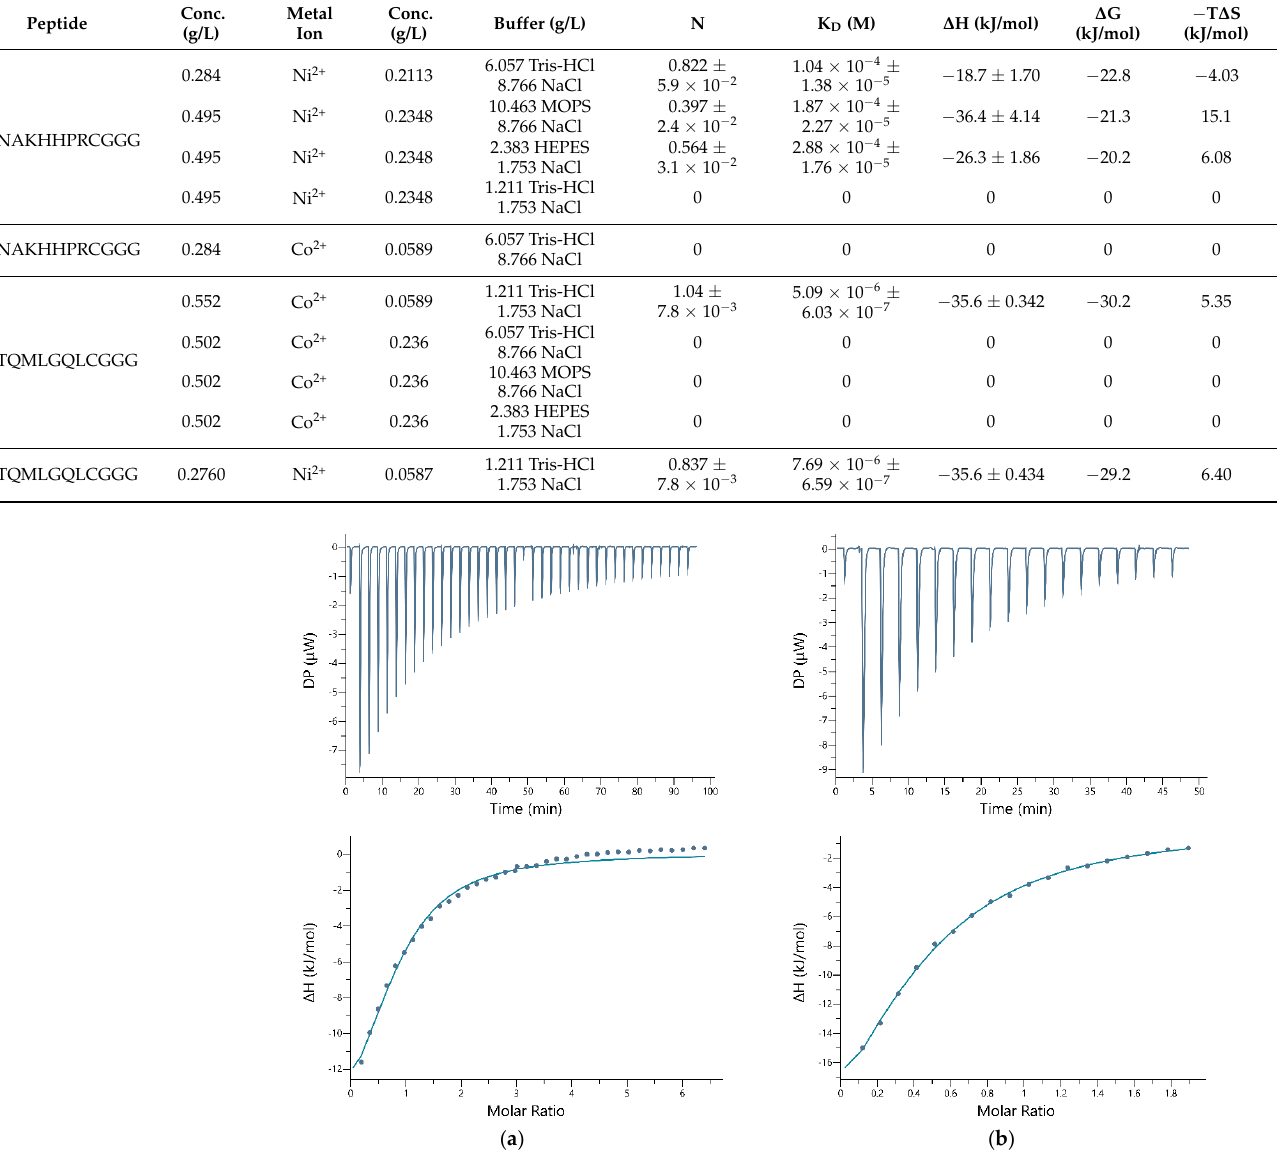
action. With an affinity constant of 5.09 × 10 − 6 M ± 6.03 × 10 − 7 , this peptide has a 20-fold greater affinity for its target ion compared with the nickel-binding cyclic peptide.